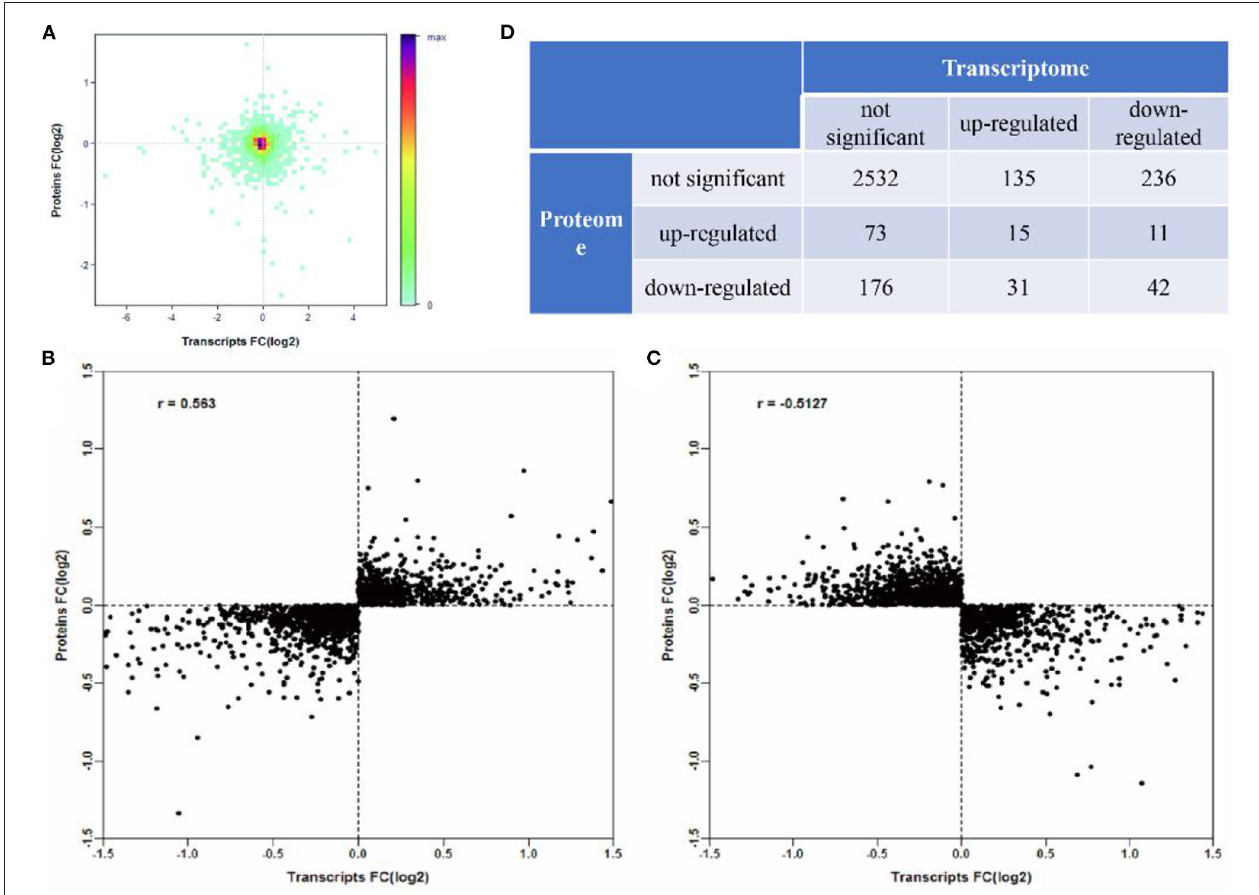
FIGURE 6 | Differential correlation of proteome-transcriptome expression. (A) The correlation between all the associated protein and messenger RNA (mRNA). (B) The distribution of correlation of consistent-changed transcriptome and proteome. (C) The distribution of correlation of different-changed transcriptome and proteome. (D) Detailed classification of expression